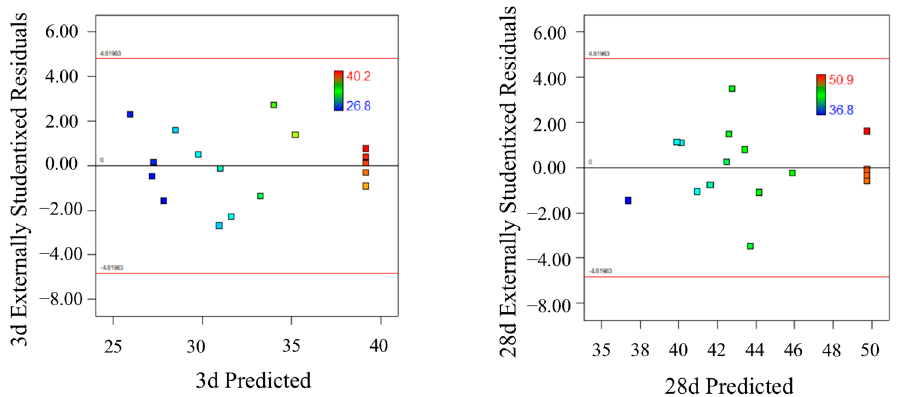
Figure 6. Plot of residuals against predicted response (3/28 d).